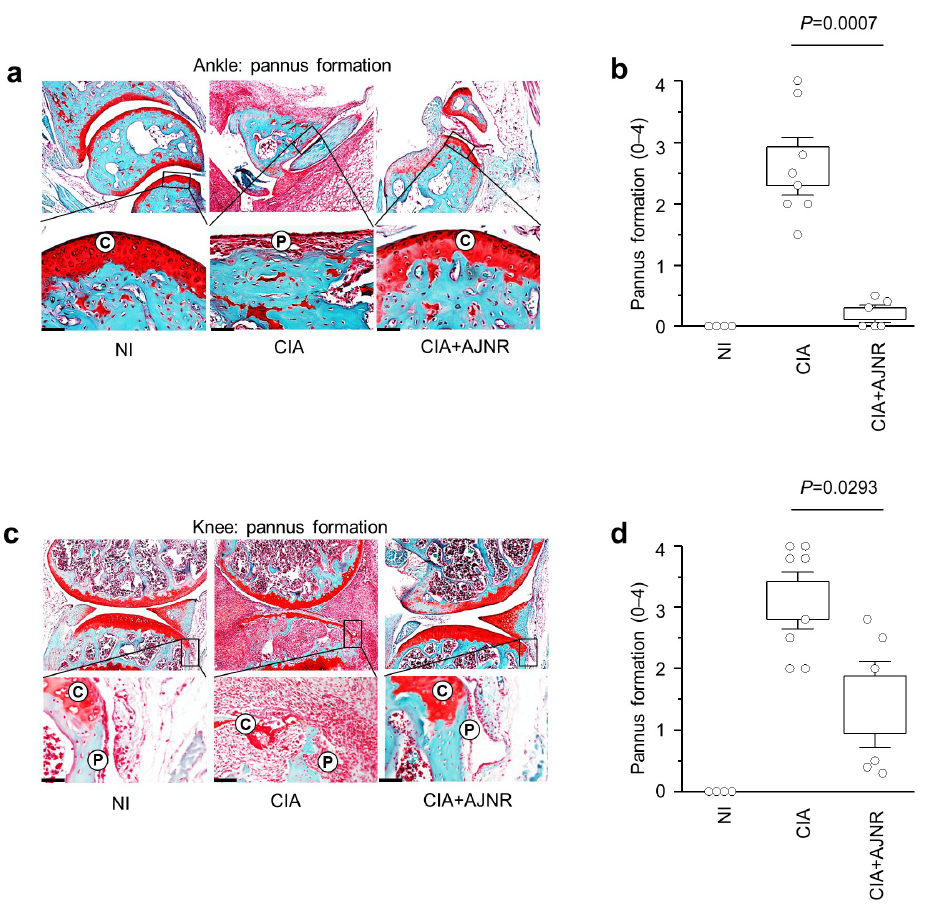
Figure 6. Inhibitory effects of AJNR in CIA-induced pannus formation. Collagenase-induced arthritis (CIA) models were established using 7-week-old DBA/1 J mice. During arthritis induction, AJNR intraperitoneal injections were administered (2 times per week for 6 weeks). ( a ) Representative Safranin-O and H&E staining images of the ankle pannus of non-immunized (NI), CIA, and AJNR- treated CIA mice. Score of ankle pannus formation is presented in ( b ) ( n ≥ 4 mice per group). ( c ) Representative Safranin-O and H&E staining images of the knee pannus of NI, CIA, and AJNR- treated CIA mice. Score of knee pannus formation is presented in ( d ) ( n ≥ 4 mice per group). The results are representative of three independent experiments. Values are presented as the mean ± SEM and were evaluated using the Mann–Whitney U test. Scale bar: 50 µ